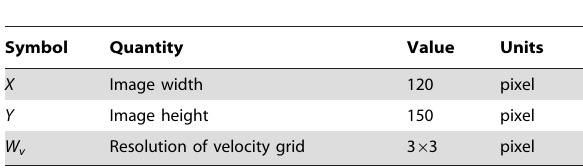
Table 2. Vorticity measurement